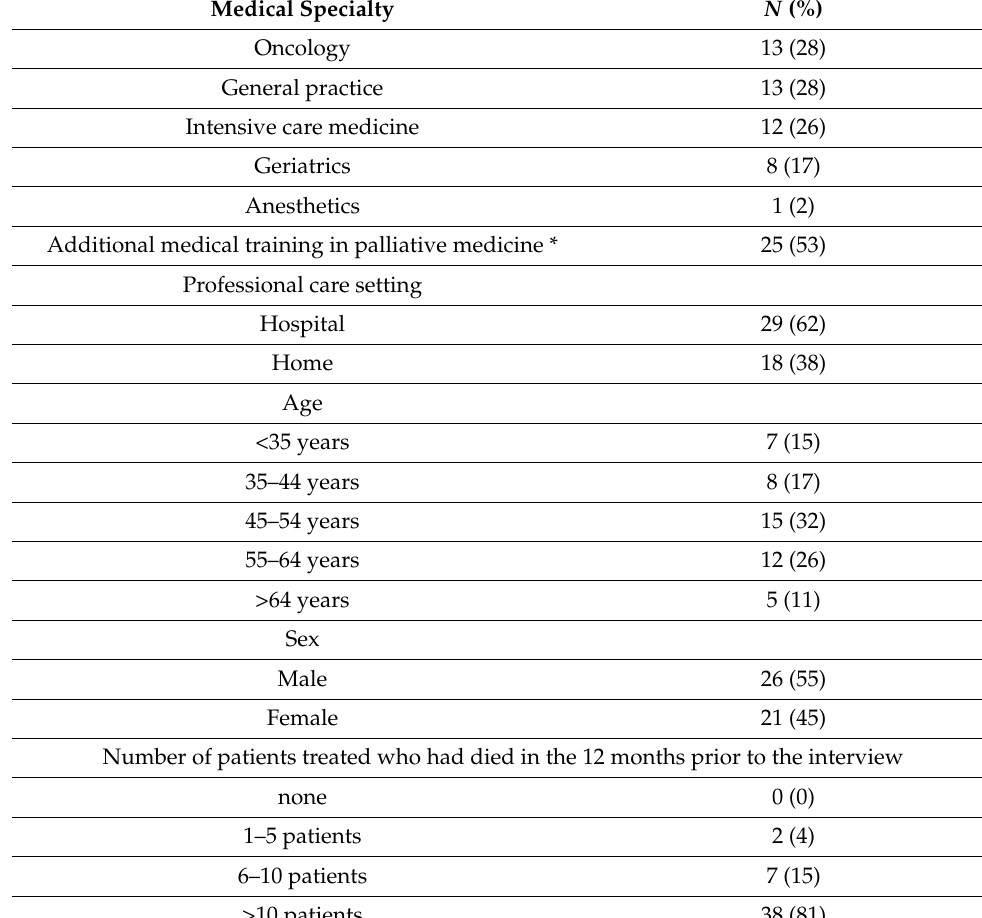
Table 1. Characteristics of the 47 participants included in the